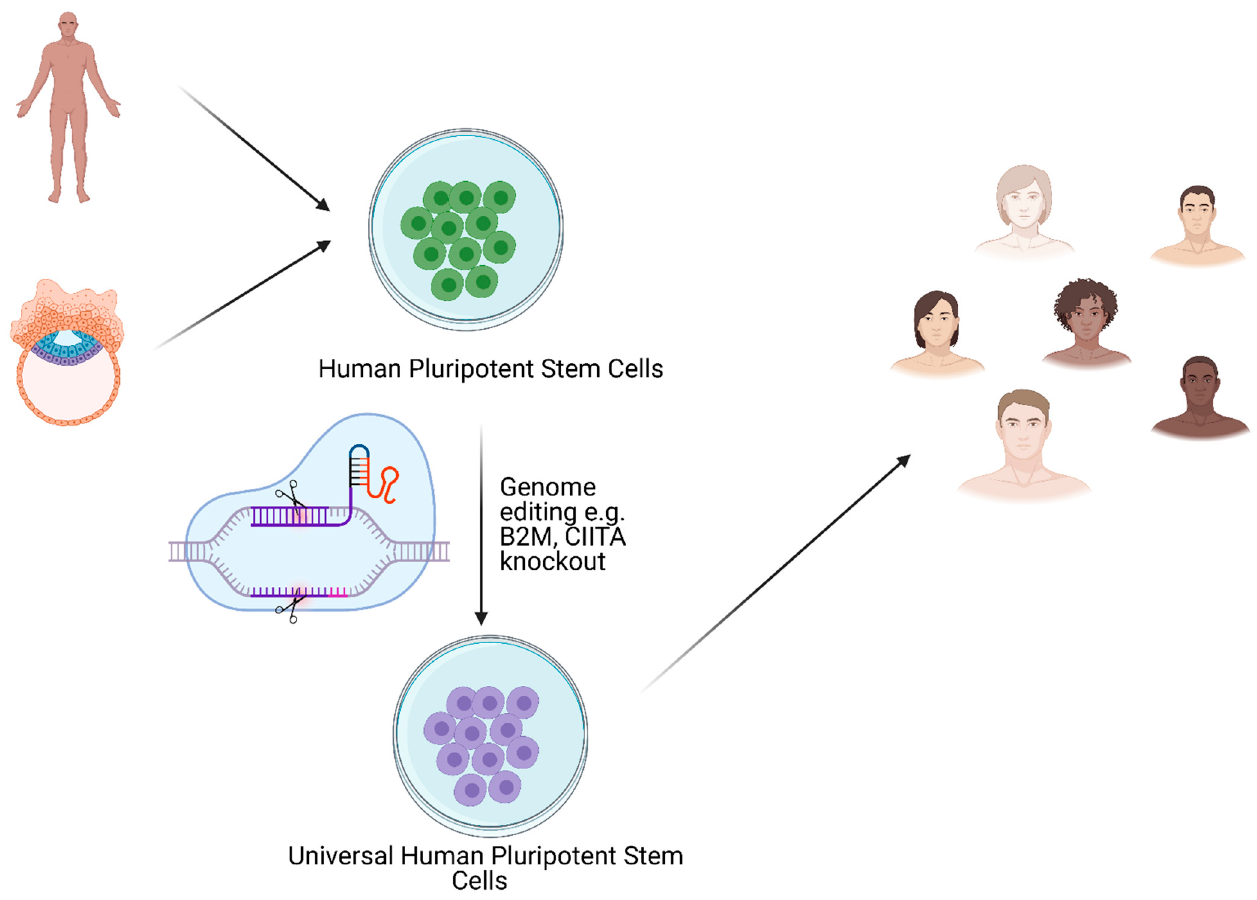
Figure 3. Possible approach for obtaining universal human pluripotent stem cell line. Created with BioRender.com accessed on 17 June